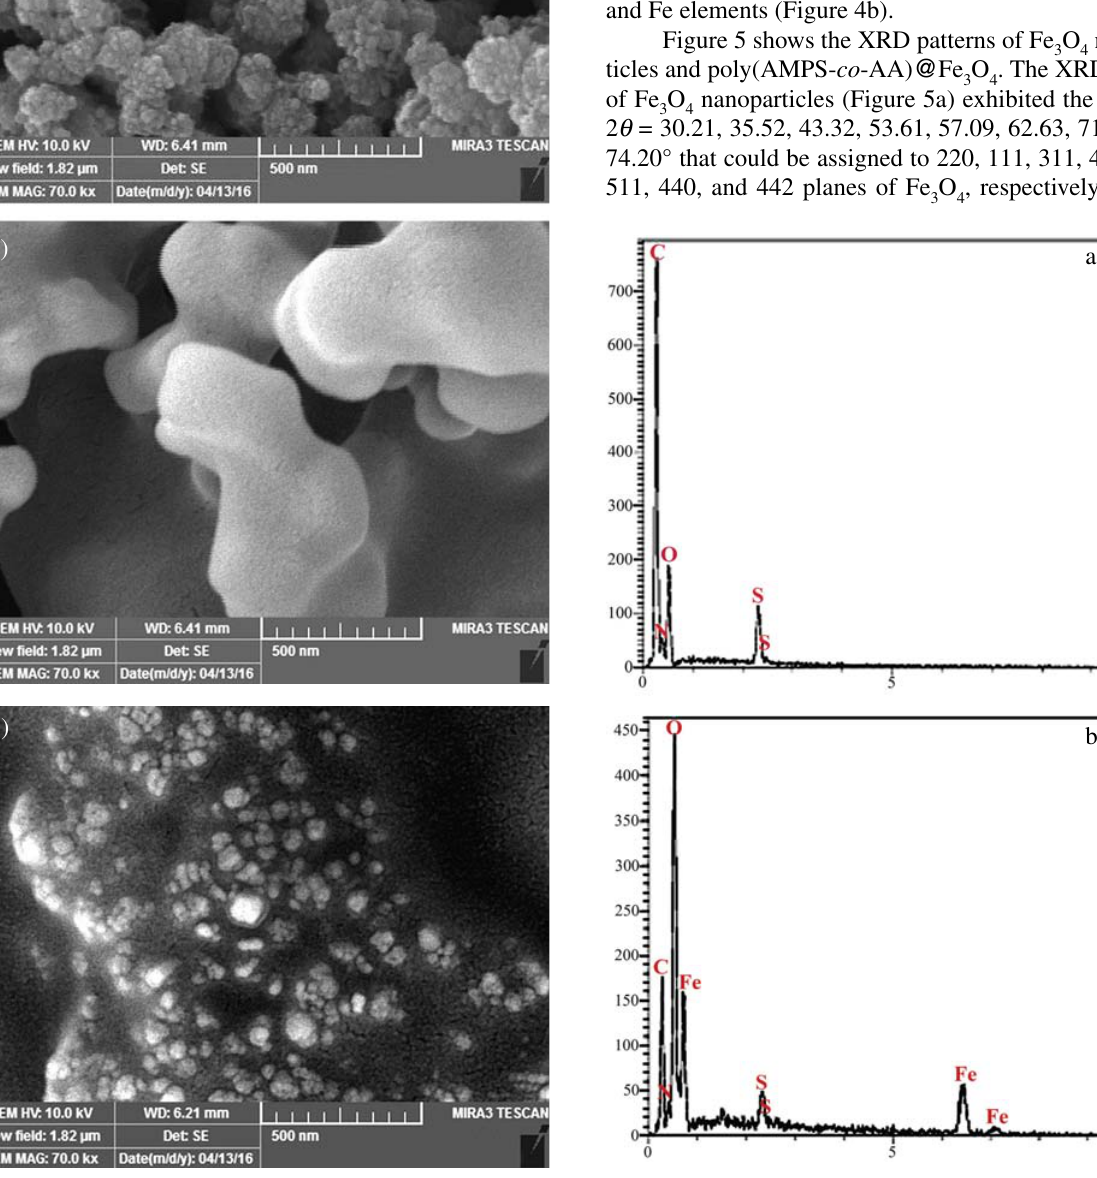
and poly(AMPS- co -AA) @ Fe